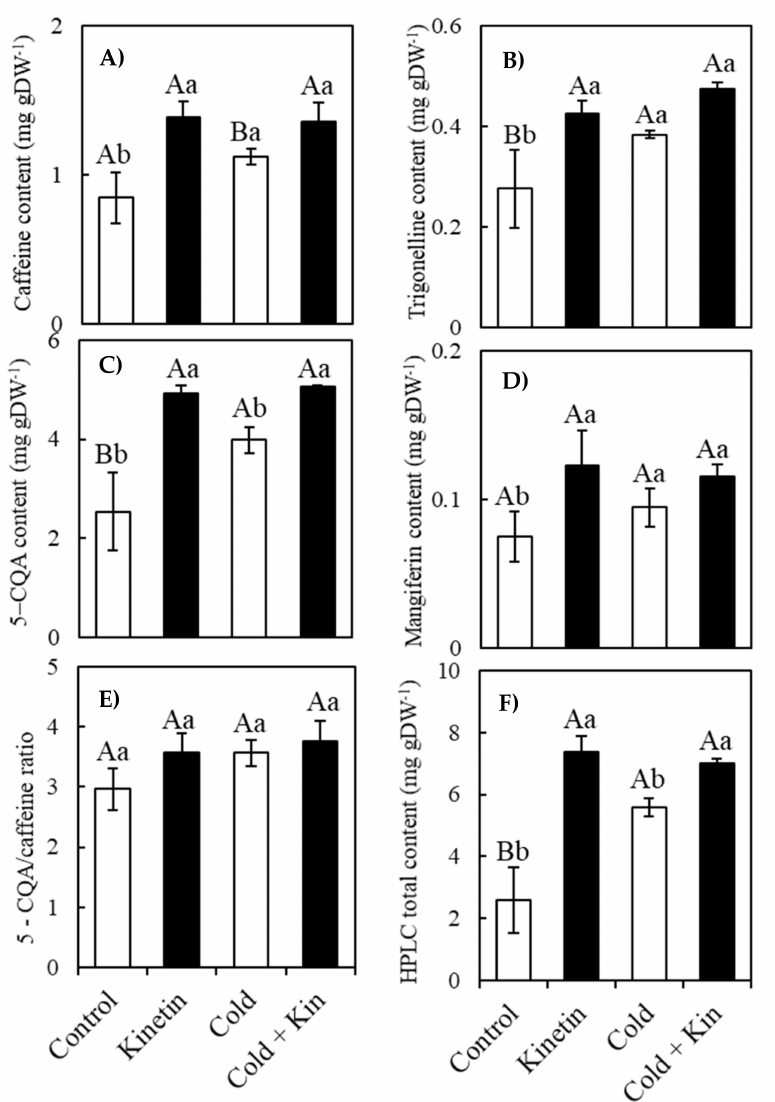
Figure 3. E ff ect of exogenous kinetin on the content of the nonenzymatic antioxidant compounds in the leaves of co ff ee plants under optimum and cold stress conditions. Ca ff eine ( A ) trigonelline ( B ); 5-ca ff eoylquinic acid ( C ); mangiferin ( D ); 5-ca ff eoylquinic acid / ca ff eine ratio ( E ) and HPLC total content ( F ). Kin, kinetin. Di ff erent capital letters, (A, B) denote statistically significant di ff erences between the parameter means within temperature treatments, whereas di ff erent small letters, (a, b) denote statistically significant di ff erences for the parameter means within kinetin treatments ( p < 0.05, Newman–Keuls test). Means are a replicate of three independent samples ( n = 3). Error bars represent the standard deviation of the